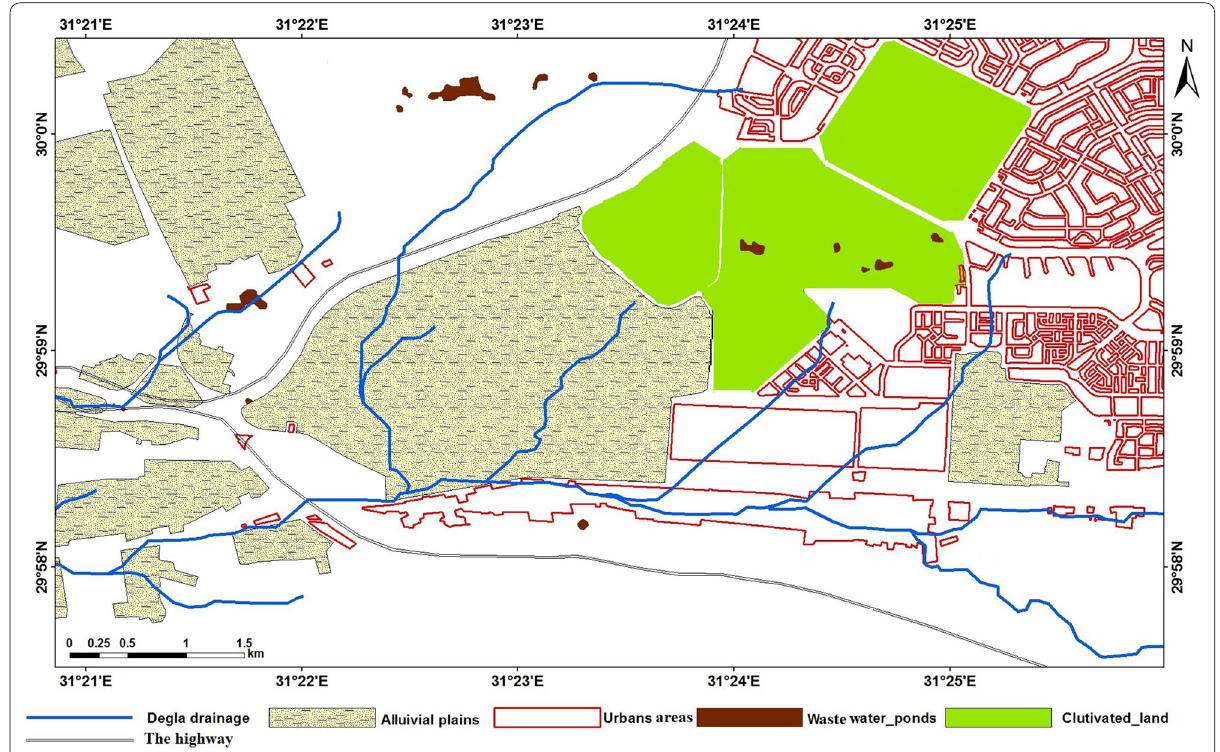
Fig. 6 The units of land use/land cover in the downstream area of Wadi